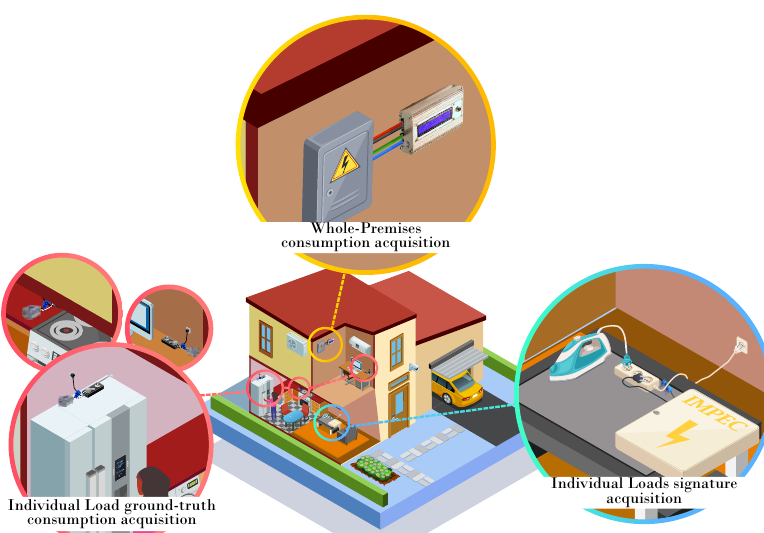
Figure 6. The three different types of the electricity consumption data contained in MORED.